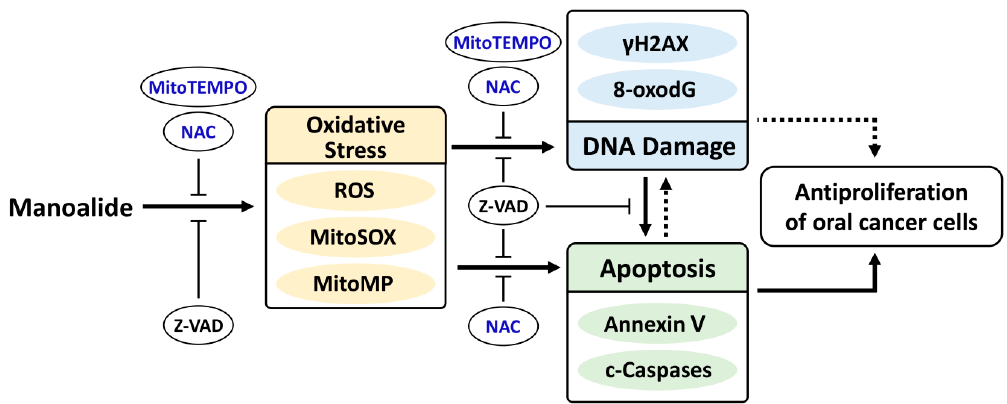
Figure 9. Expected mechanism of manoalide-induced preferential antiproliferation on oral cancer cells. Manoalide may preferentially kill oral cancer cells by inducing oxidative stress, such as ROS and MitoSOX productions, as well as MitoMP depolarization. These oxidative stresses may induce DNA double strand break damage and oxidative DNA 8-oxodG DNA damage. DNA damage may